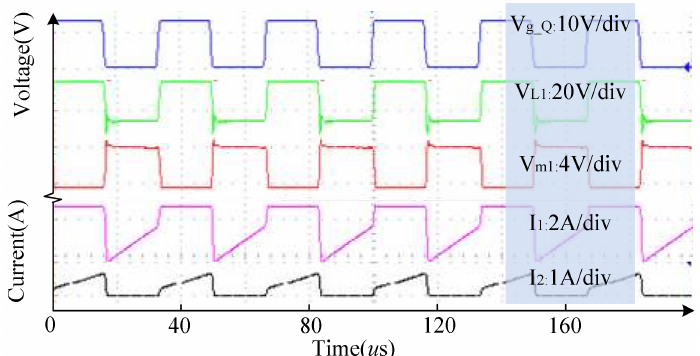
Figure 9. The voltage and current waveforms of tapped inductor L 1 during the balancing progress. (CH1. V g_Q is gate signal of switches Q 1 and Q 2 ; CH2: V L 1 is voltage between the whole turns of the L 1 ; CH3: V m 1 is voltage between the left side of the L 1 ; CH4: I 1 is current flows across Q 1 ; CH5: I 2 is current flows across S 1